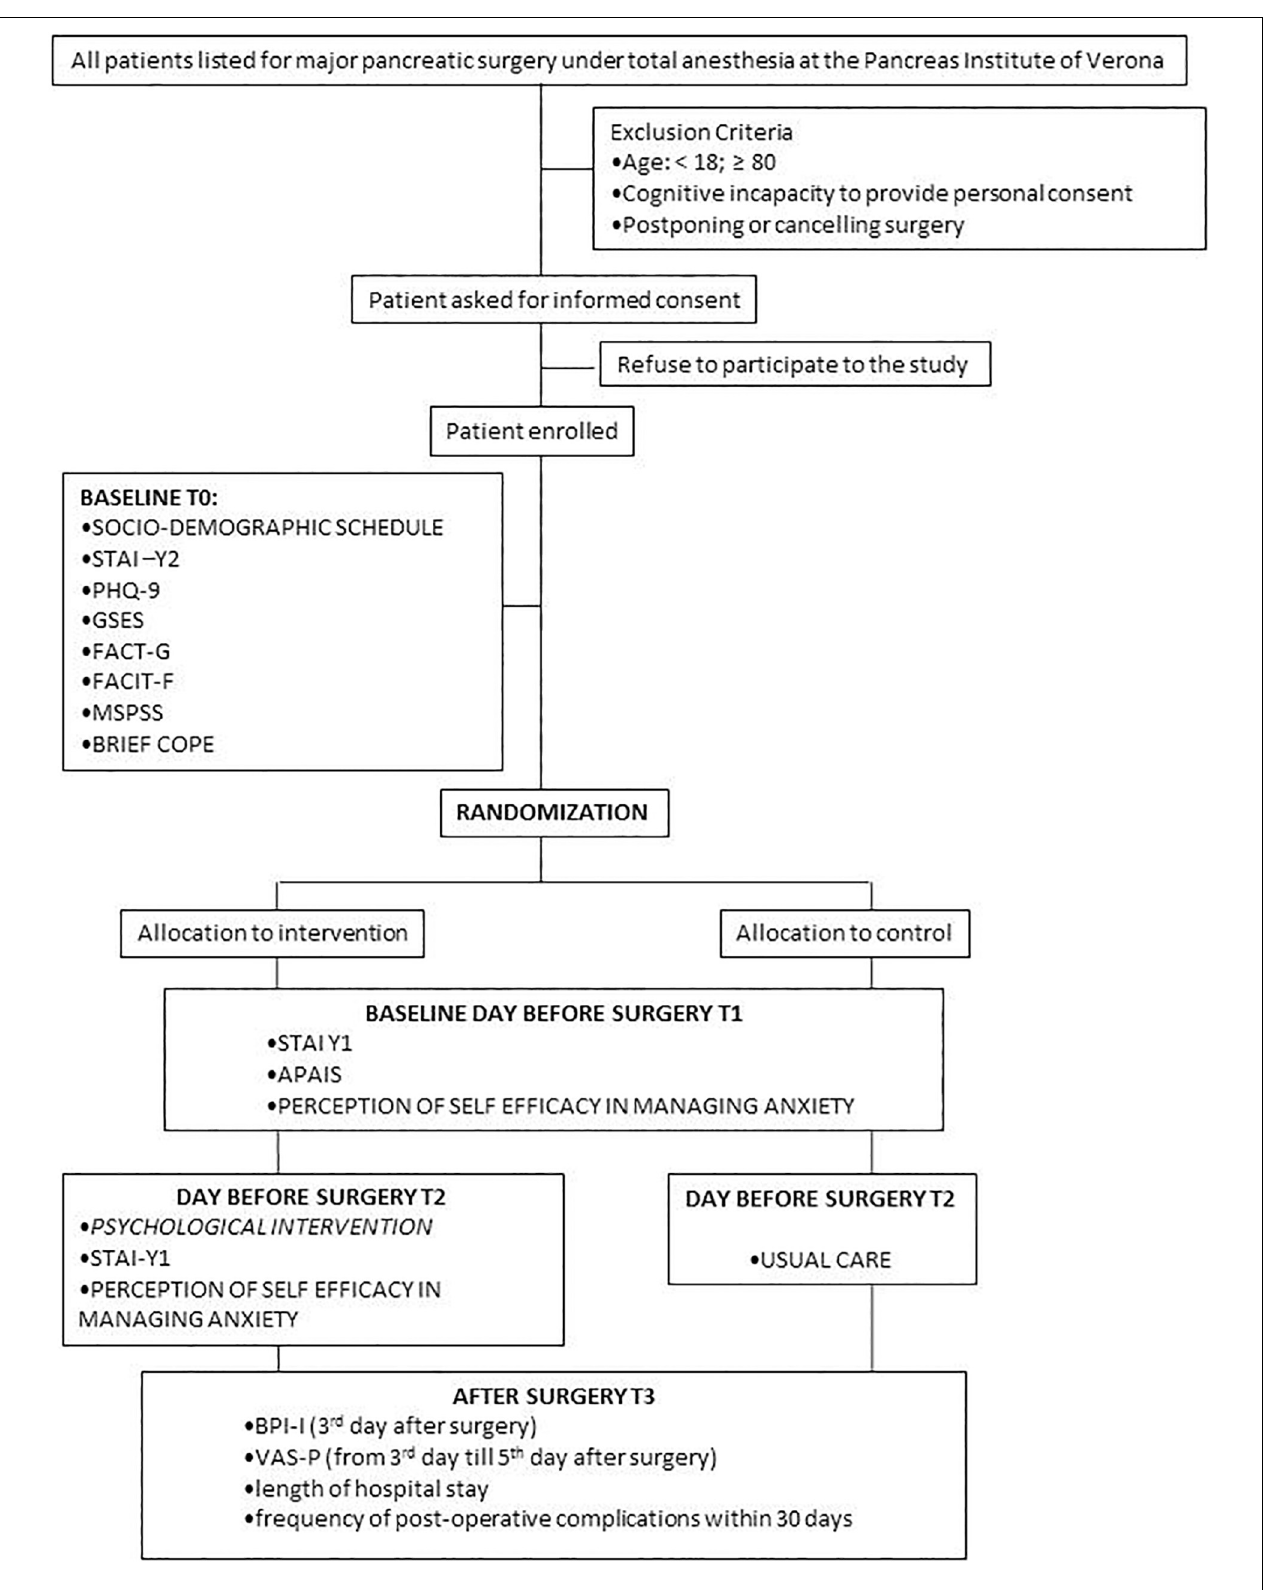
FIGURE 2 | Flow chart of the study